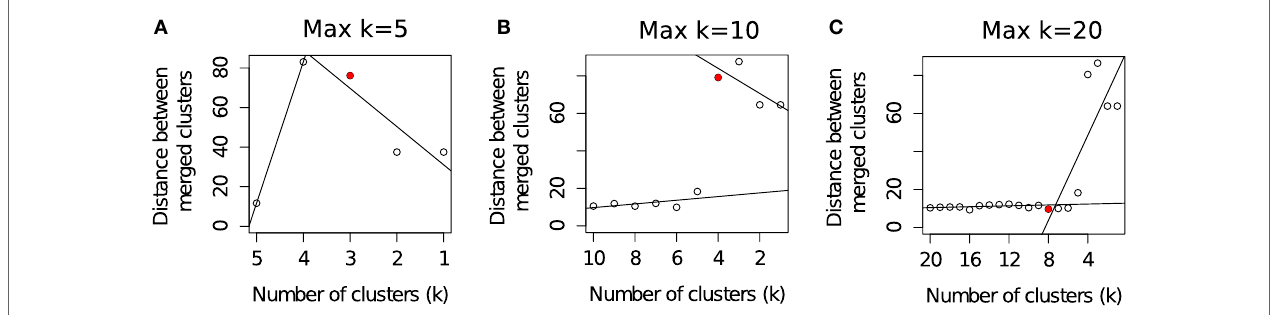
FigUre 3 | selecting the optimum number of cell populations in a sample from the hD dataset by the flowMeans package (18) . The maximum number of clusters is set to: (a) 5 clusters (automatically selected by algorithm), (B) 10 clusters, and (c) 20 clusters. The optimum number of clusters is selected by detecting change point in the segmented regression lines and is shown with a red filled circle in each